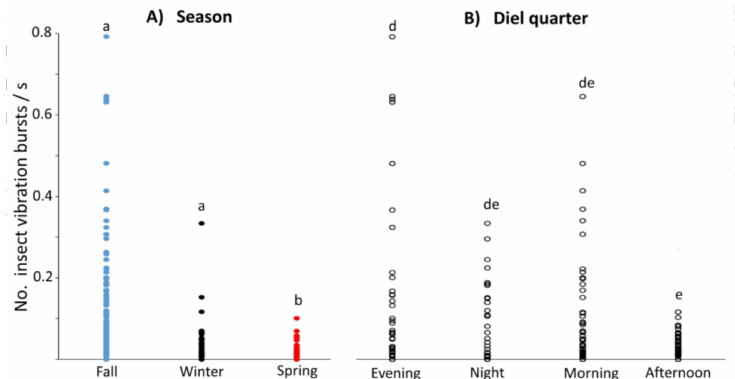
Figure 4. Rates of insect vibration bursts recorded in di ff erent ( A ) seasons and ( B ) diel quarters. Rates in di ff erent seasons are marked by dots: blue, black, and red for fall, winter, and spring, respectively. Seasons headed by the same letter are not significantly di ff erent by the non-parametric Steel–Dwass posthoc test. Rates in di ff erent diel quarters are marked by open circles. Diel quarters with headings containing the same letter are not significantly di ff erent by the Steel–Dwass test.